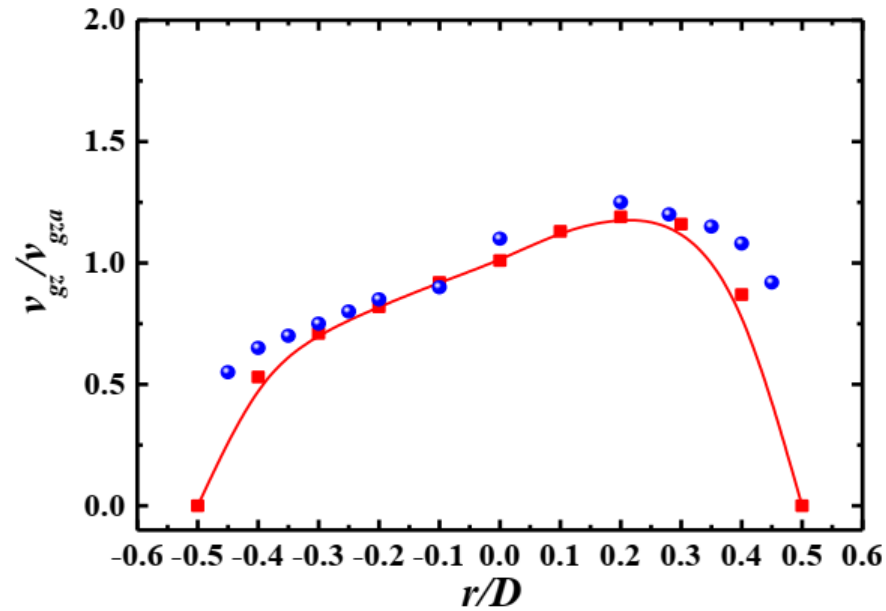
Figure 3. Distribution of gas velocity along the radial direction ( α s = 5%, V = 7 m/s). (cid:4) : present results • : experimental results